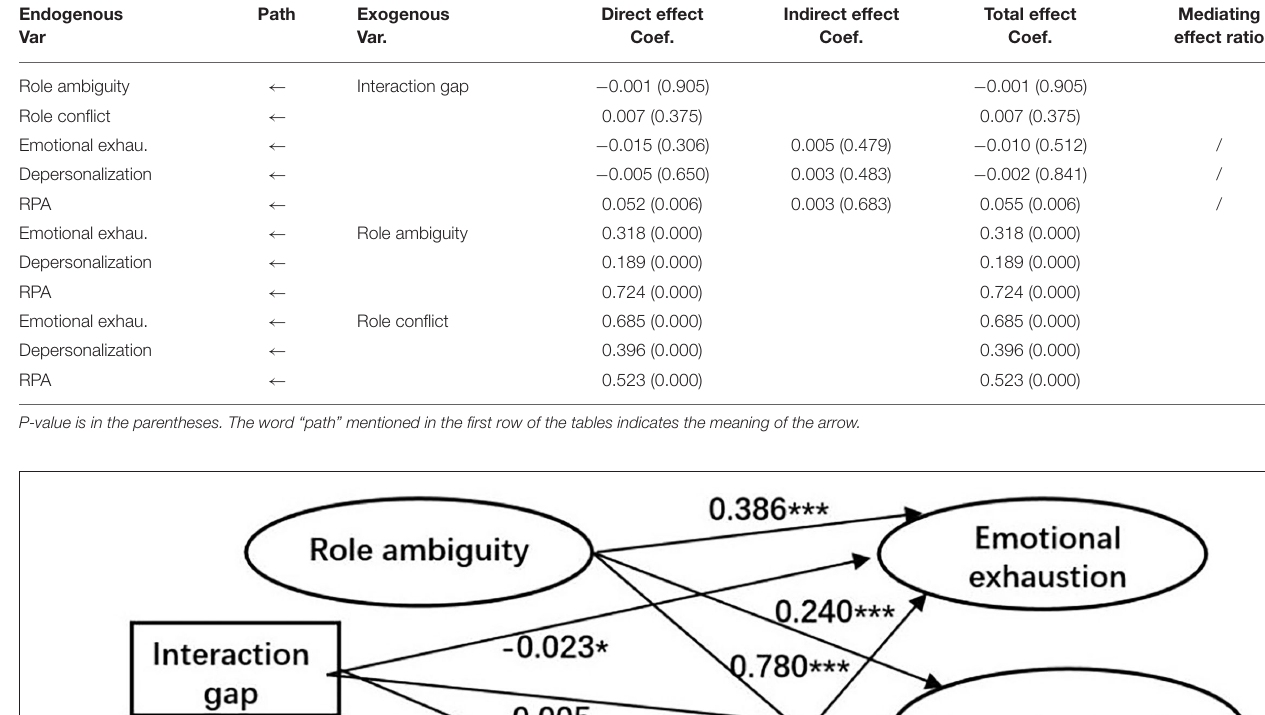
TABLE 6 | Standardized direct, indirect, and total effect and mediating effect ratio for the sample of Non-front-line social workers. Endogenous Var